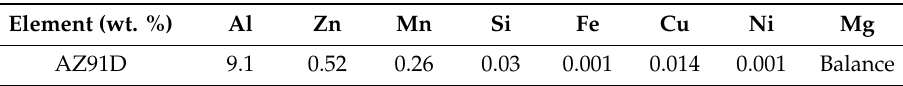
Table 1. The chemical composition of the AZ91D magnesium alloy substrate. Element (wt.